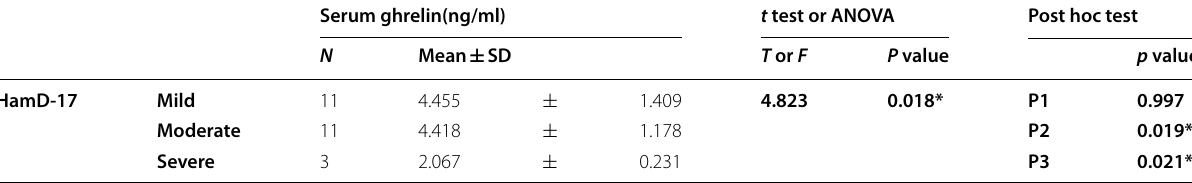
* with significance